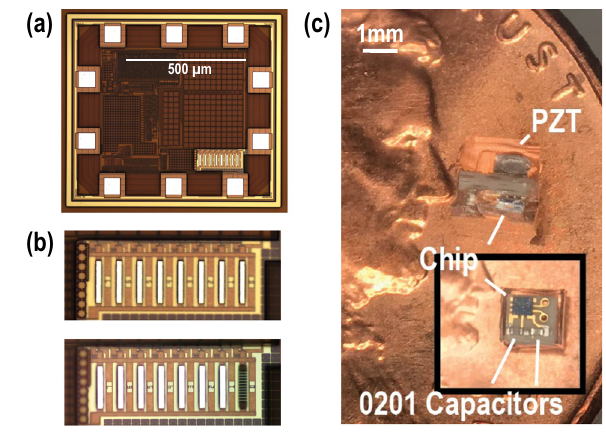
Fig. 4 Fabricated IC. a Die micrograph; b an example of a processed fuse; and c a fully integrated